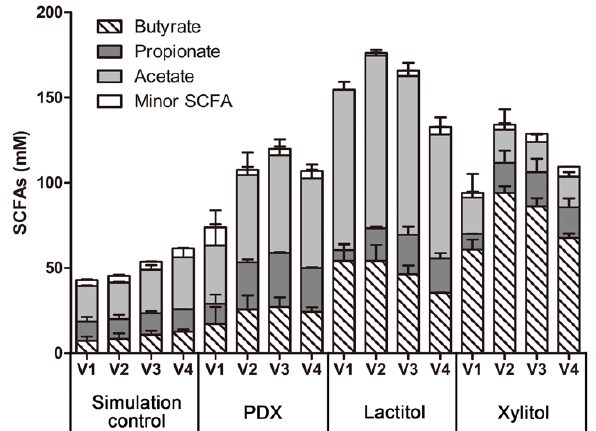
Figure 1. Overall SCFA production profile during in vitro fermentation. Polydextrose (PDX), lactitol and xylitol was fermented in vitro by the EnteroMix fermentation model, simulation medium was used as simulation control (SC) (n = 2). The production of acetate, propionate, butyrate and minor SCFAs (iso-butyrate, 2-methylbutyrate, isovalerate, valerate, lactate) was measured. V1–V4, vessel 1 to vessel 4, represent the ascending, transverse, descending and sigmoid colon. Data are presented as mean ± SEM (mM). For detailed statistical analysis, see Figure 2.